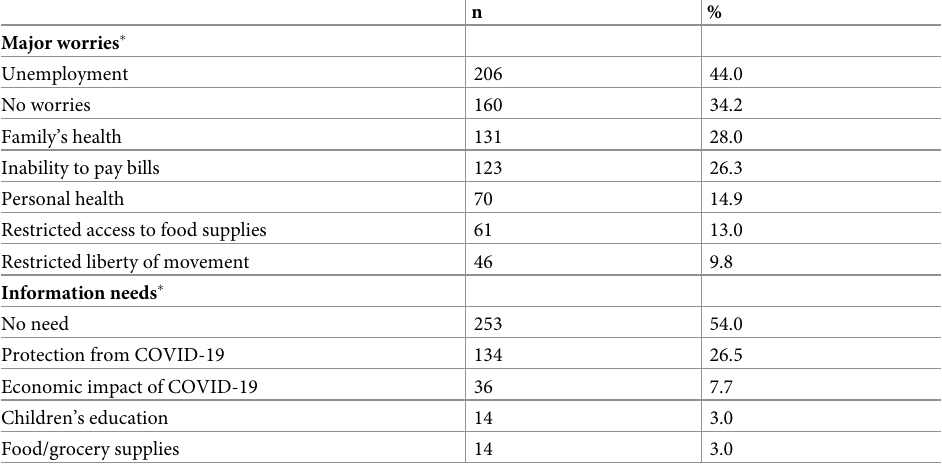
Table 7. Worries and information needs of the survey participants among Dharavi residents, Mumbai, India (N = 468).